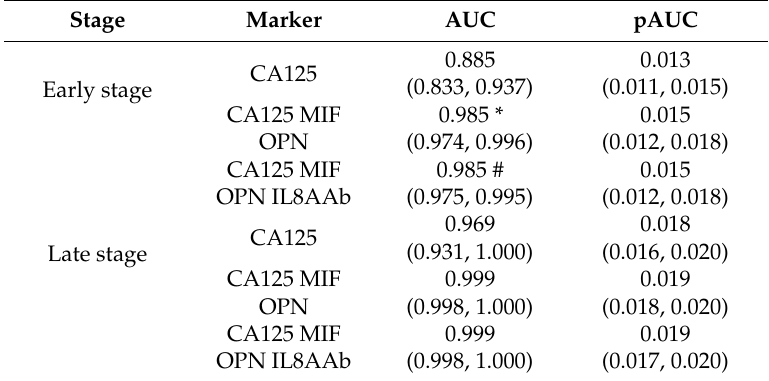
Table 2. Comparison of AUC and pAUC for biomarker models in the discovery set.